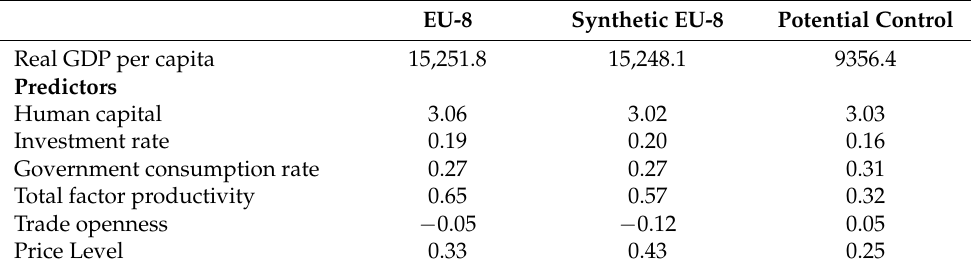
Table 2. Pre-EU accession